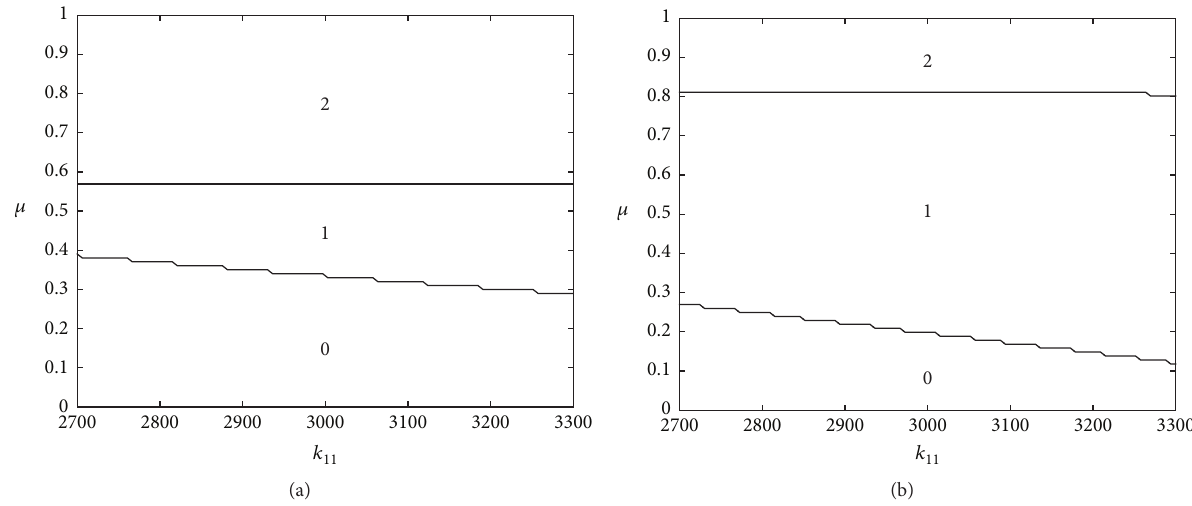
Figure 4: Number of unstable modes versus 𝜇 and 𝑘 11 for configurations 1 (a) and 2